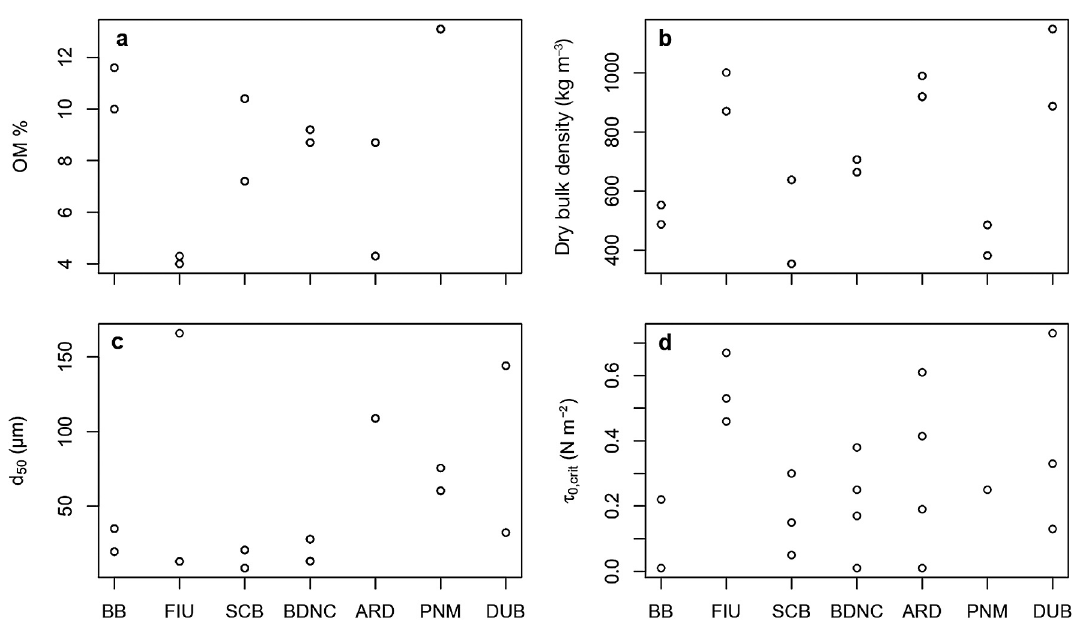
Fig. 3. Far-field survey data, with data points grouped by survey site (ordered north to south). (a) Organic matter (OM) percentage; (b) dry bulk density; (c) median grain size (d 50 ); (d) critical entrainment stress ( τ 0,crit ). Site codes defined in Table